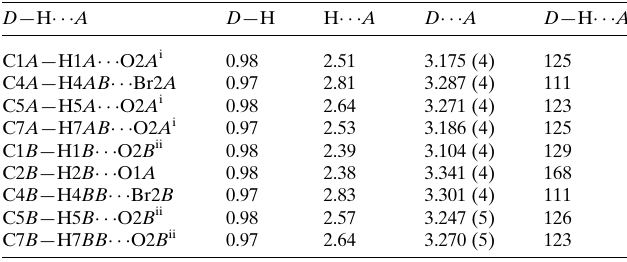
Table 1 Hydrogen-bond geometry (A˚ , (cid:3)